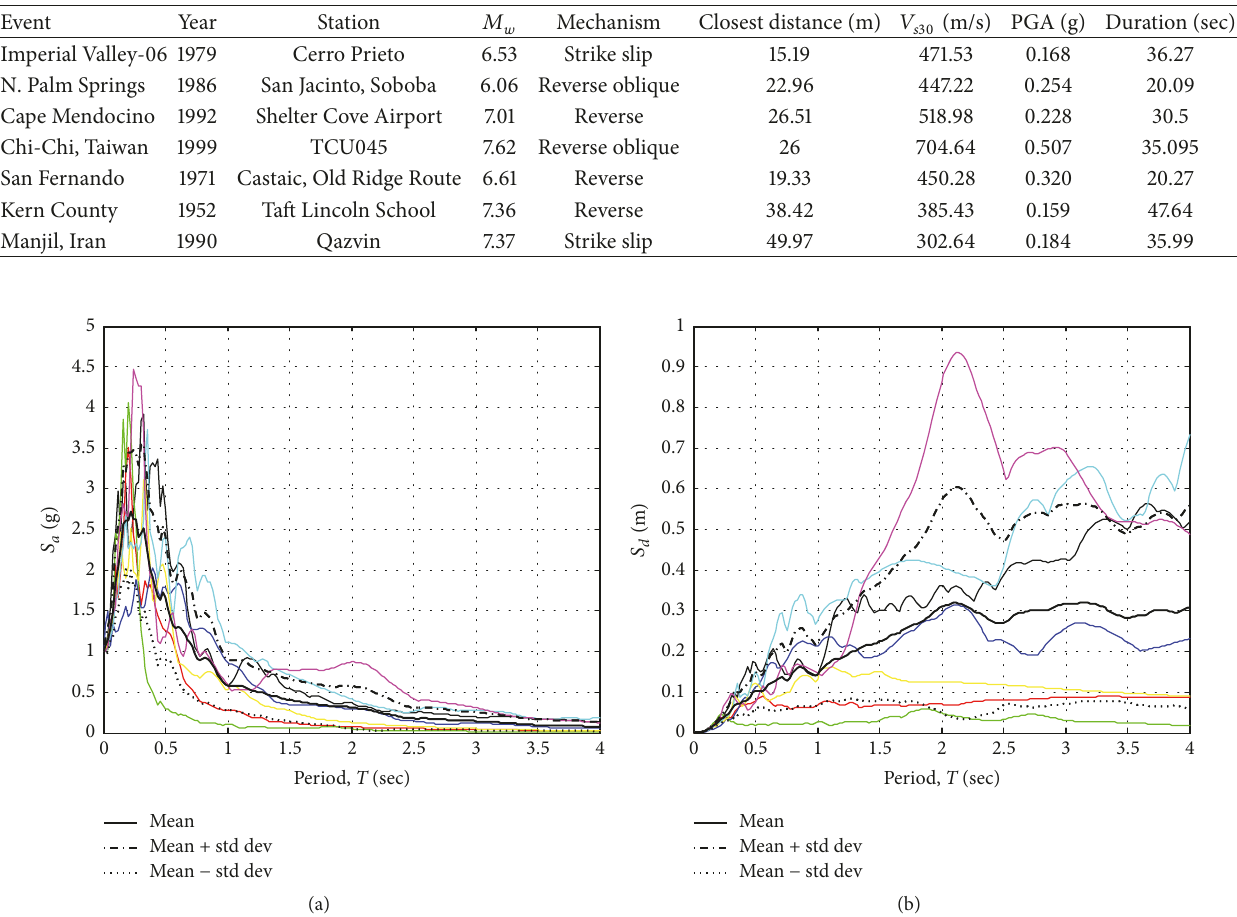
Figure 6: The response spectra of records ( 𝜉 = 0.05): (a) pseudo-acceleration and (b) displacement. Thin curves are the response spectra of earthquake records in Table